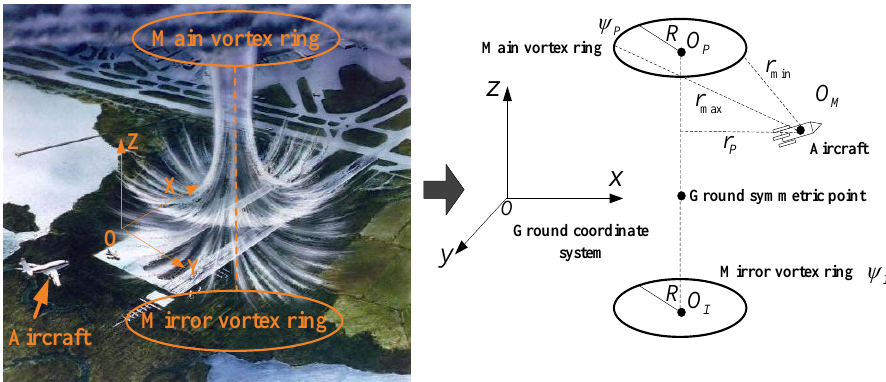
Figure 2. Coordinate system of micro-downburst model.